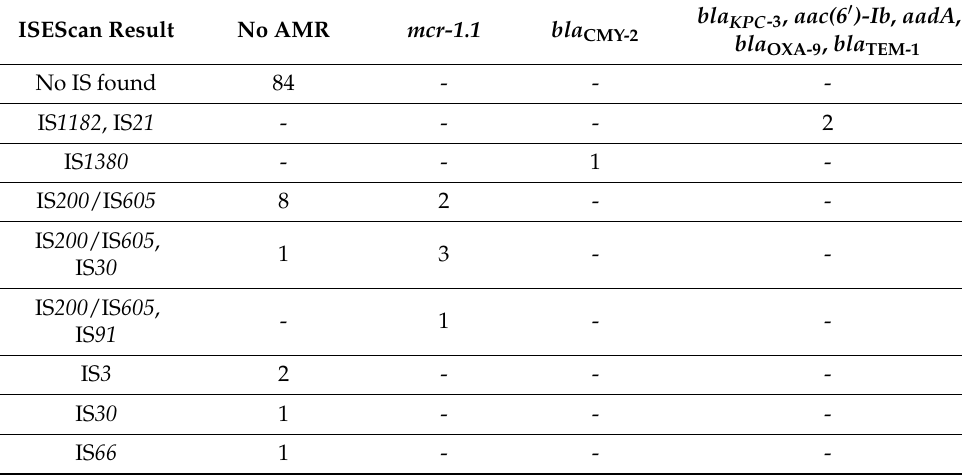
Table 2. Distribution of IS elements within USA IncI2 plasmids analyzed. Please note that IS 30 , IS 1182 and IS 1380 are the only IS elements directly associated with antibiotic resistance genes in these